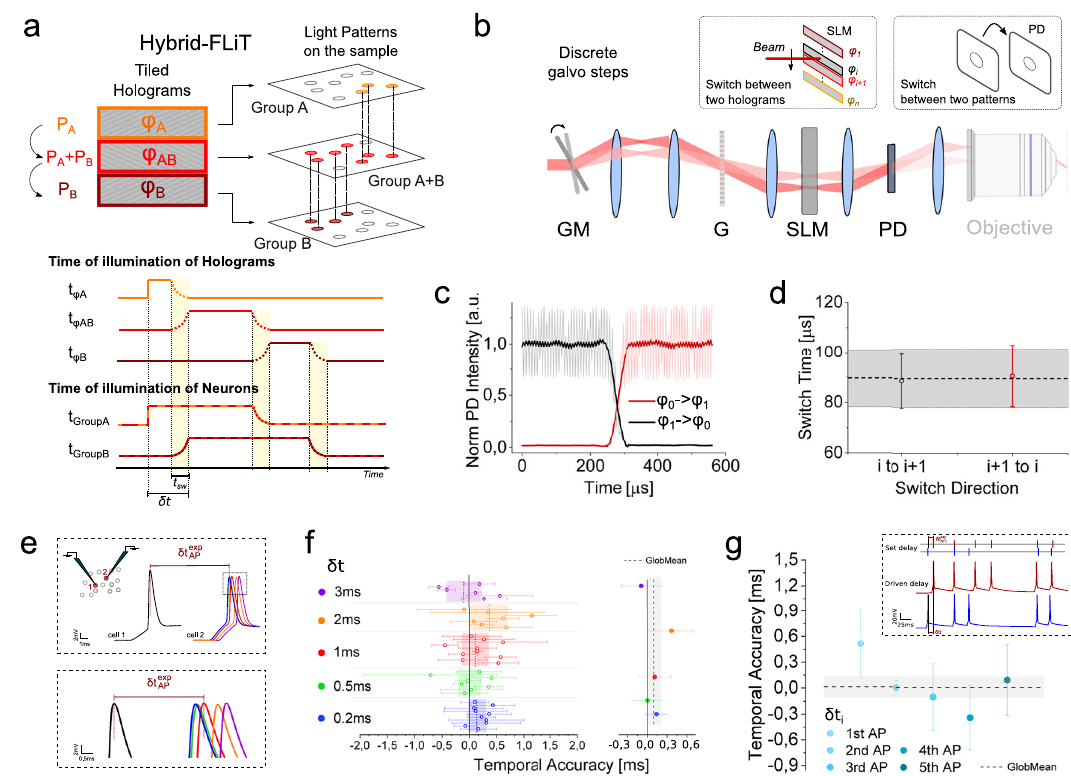
Fig. 2 | Tuning of neuronal activity in targeted neurons by hybrid -FLiT. a Conceptual scheme of hybrid -FLiT. The LC-SLM is tiled in different regions each encoding different phase masks. In the present example, phase mask φ A and φ B encode for group of spots A and B, while phase mask φ AB encodes for a compre- hensive pattern including group A and group B. By steering the beam vertically across the phase masks with predetermined dwell-times and illumination inten- sities per each mask, it is possible to set arbitrary delays of activation between groups of spots. In the illustrated example, the illumination dwell time is t φ A , t φ AB , t φ B , and the illumination power is P A , P A + P B , P B on the holograms φ A , φ AB , φ B , respectively. On comprehensivephase mask φ AB , the distribution of intensitymust be computationally set to maintain an amount of power P A and P B on subgroup A and B, respectively. Overall, this scheme yields an activation time t φ A +t φ AB for groupA,t φ AB +t φ B forgroupBandadelayofactivationbetweengroupAandgroup B δ t equivalent to t φ A . t sw represents the switching time of the GM unit. Yellow vertical bands indicate the switching time t sw . The scheme displayed is meant to represent n groups of spots; their number is here limited to 2 for presentation purposes only. b Measurement of the switching time between two adjacent tiled holograms( φ i and φ i+1 ) whengalvomoves inone discrete step.Aphotodiode(PD) is placed in an image conjugate plane while driving thegalvanometric mirror (GM) with a small-angle single-step voltage input. c Representative intensity response of the PD when GM is switched from hologram φ 1 (encoding for an individual spot in themiddleofPD)tohologram φ 0 (deviatingthebeamoutofthePD)(blackline)or, viceversa(redline).SLMwassubdividedin20holograms. d Switchtimecalculated as the time taken for the signal to rise/fall between 3% and 97% of the maximum intensity, when the spot is encoded in hologram φ i and GM is switched from hologram φ i to φ i+1 (black symbols) or vice versa (red symbols). Horizontal black line and shaded gray band indicate the global mean and SD switching time,